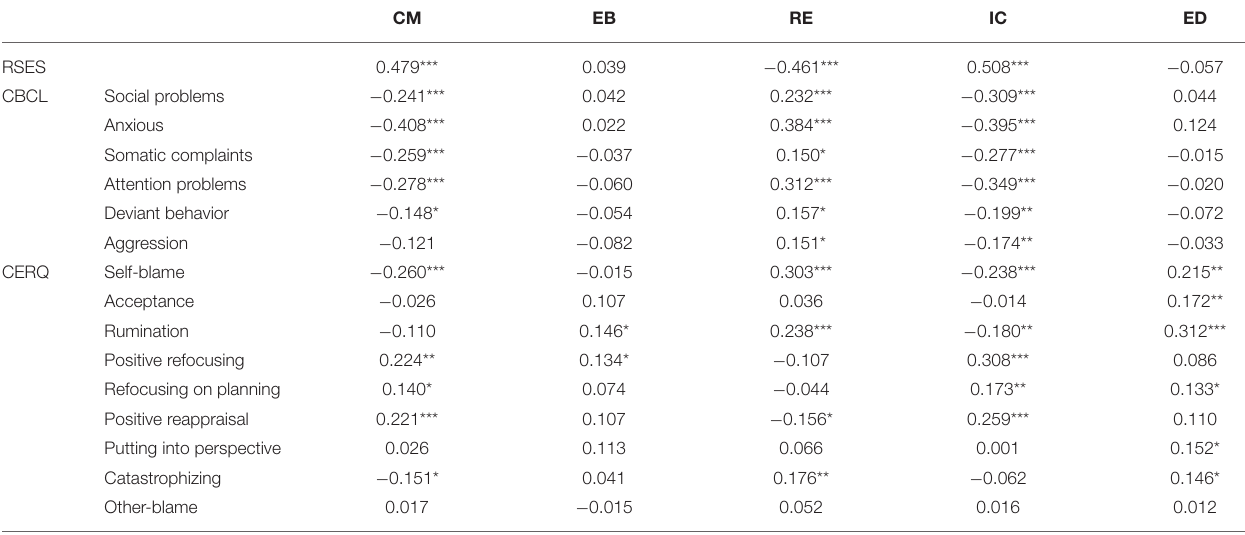
TABLE 4 | Relationship between the five dimensions of H-DIDS and measured variables; results of Pearson’s